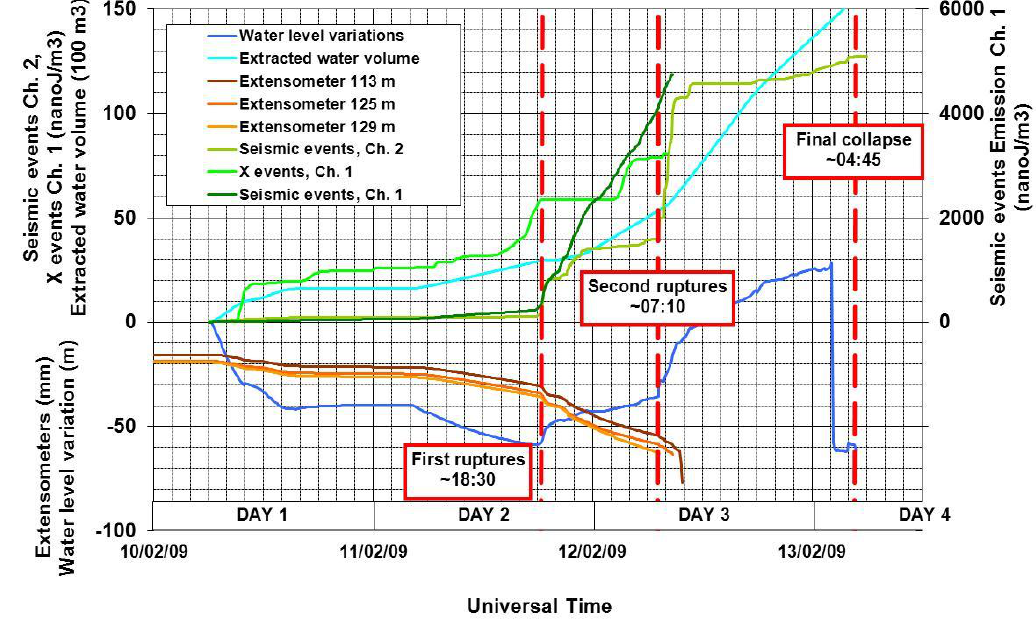
Figure 5 – Evolution of stress, strain and AE energy during the controlled collapse. 3 Fig. 5. Evolution of stress, strain and AE energy during the controlled